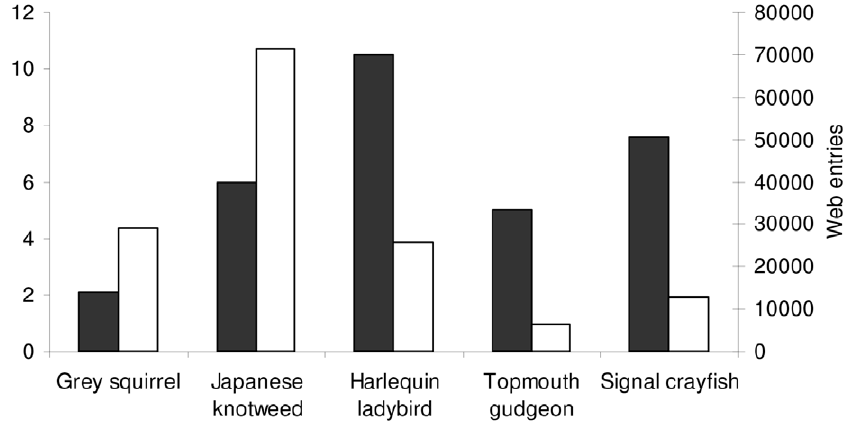
Figure 4. Correlation between scientific research and media concerning invasive species resident in the UK. Publication rate per annum (black) and web entries (number of internet hits) (white) concerning non-native species in the UK.